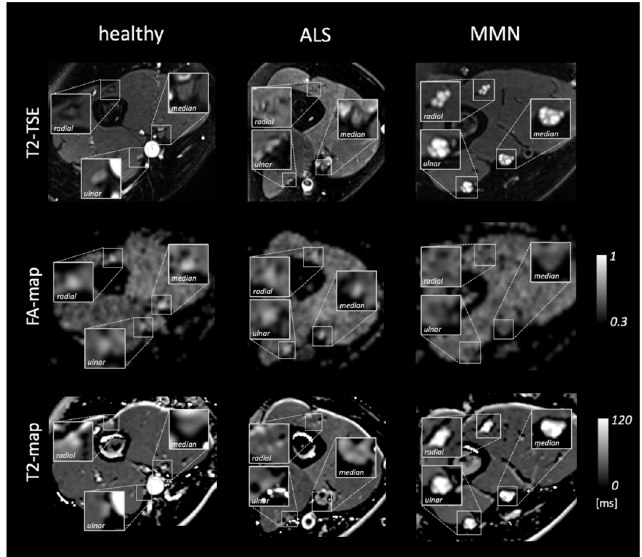
Figure 1. Representative images of a healthy subject and patients with amyotrophic lateral sclerosis (ALS) or multifocal motor neuropathy (MMN). From top to bottom, the rows show representative images of the T2 turbo spin echo (TSE) sequence, the corresponding parameter map of fractional anisotropy (FA-map), and T2-map based on the T2-relaxometry sequence. Insets show a magnification of the median, radial, and ulnar nerves.